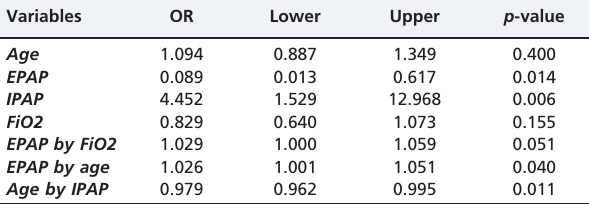
Table 5 - Factors associated with noninvasive ventilation failure – multiple logistic regression, final model.